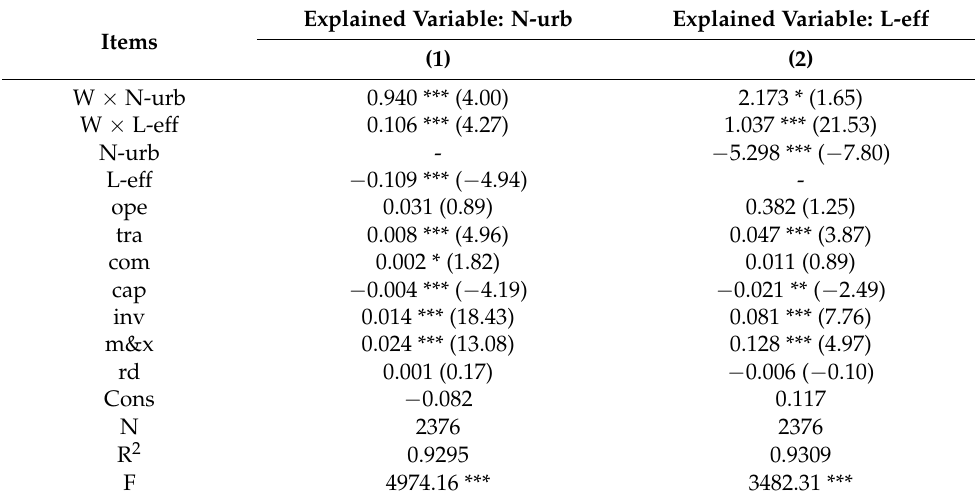
Table 6. Parameter estimation results of SS-equations and the